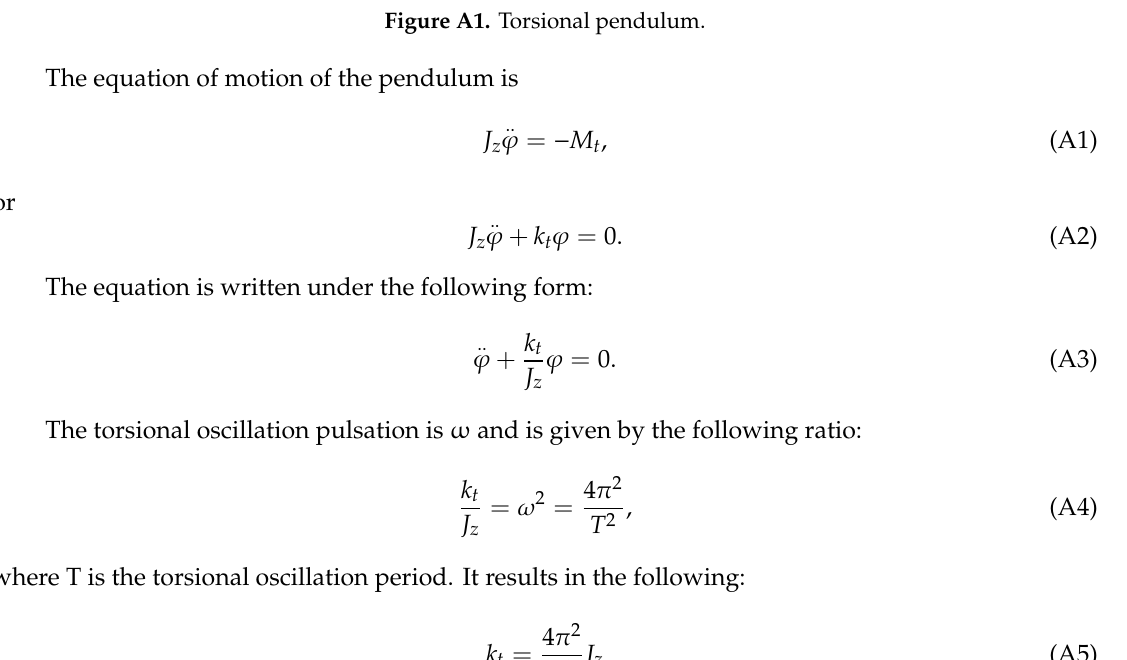
Figure A1. Torsional pendulum.